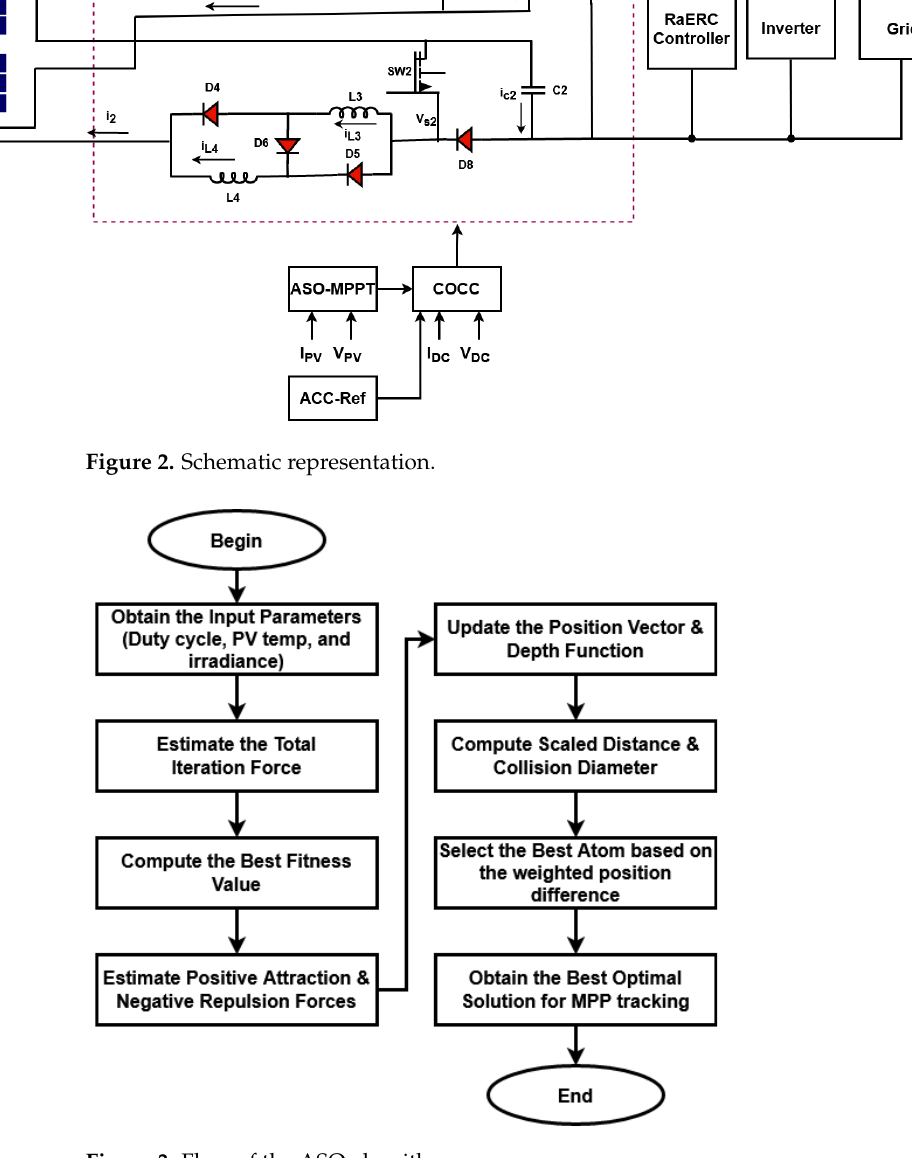
Figure 3. Flow of the ASO algorithm.